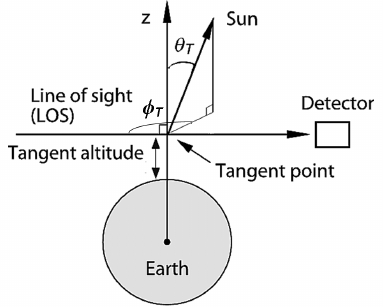
Figure 5. Illustration of the limb-scattering viewing geometry, in- cluding definitions of the tangent altitude h and tangent point. The solar zenith angle and solar azimuth angle at the tangent point are indicated by θ T and φ T , respectively. Adapted from Fig. 1 of (Grif- fioen and Oikarinen, 2000). Note that a frequently committed error in the definition of φ T (Griffioen and Oikarinen, 2000; Loughman et al., 2004; Bourassa et al., 2008b) has been corrected: a beam with (cid:50) = 0 ◦ (scattered exactly forward) has φ T = 0 ◦